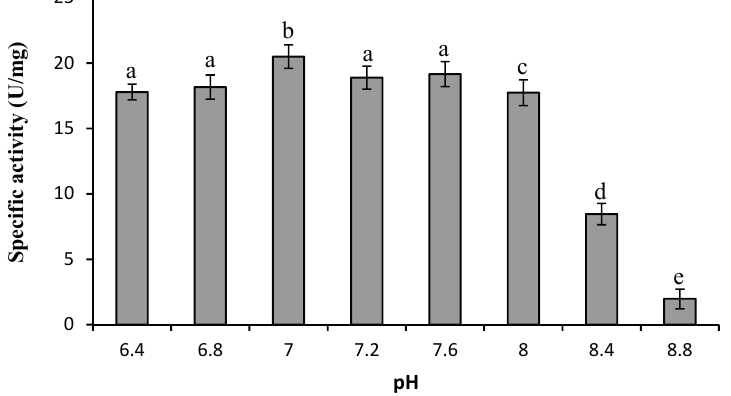
Figure 1. Effect of extraction pH on activity of Bentong ginger protease. Different letters indicate significant differences at p ≤ 0.05.